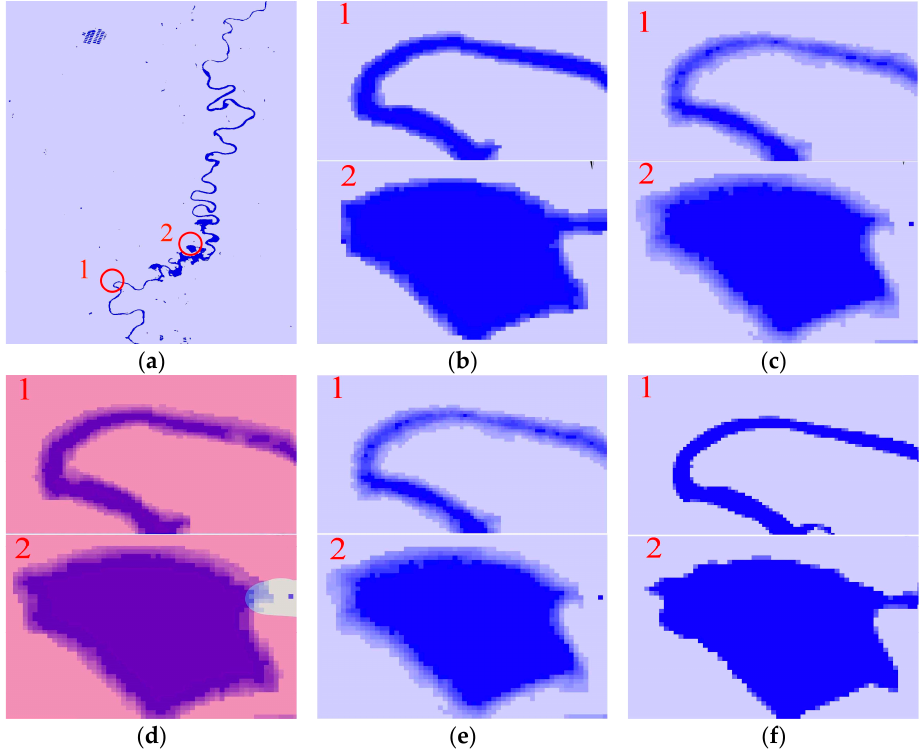
Figure 8. Decomposition results for the Yinma River Basin. ( a ) The overall decomposition results in the Yinma River Basin. ( b ) Decomposition results of the optical image in the Yinma River (without clouds). ( c ) Decomposition results of the SAR image in the Yinma River (without clouds). ( d ) Decomposition results of the spliced image in the Yinma River. ( e ) Decomposition results of the SAR image in the Yinma River (with clouds). ( f ) Measured water map of the Yinma River.